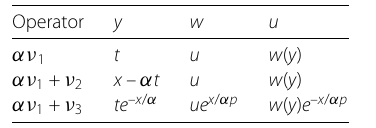
Table 3 Invariant of Eq. (1)